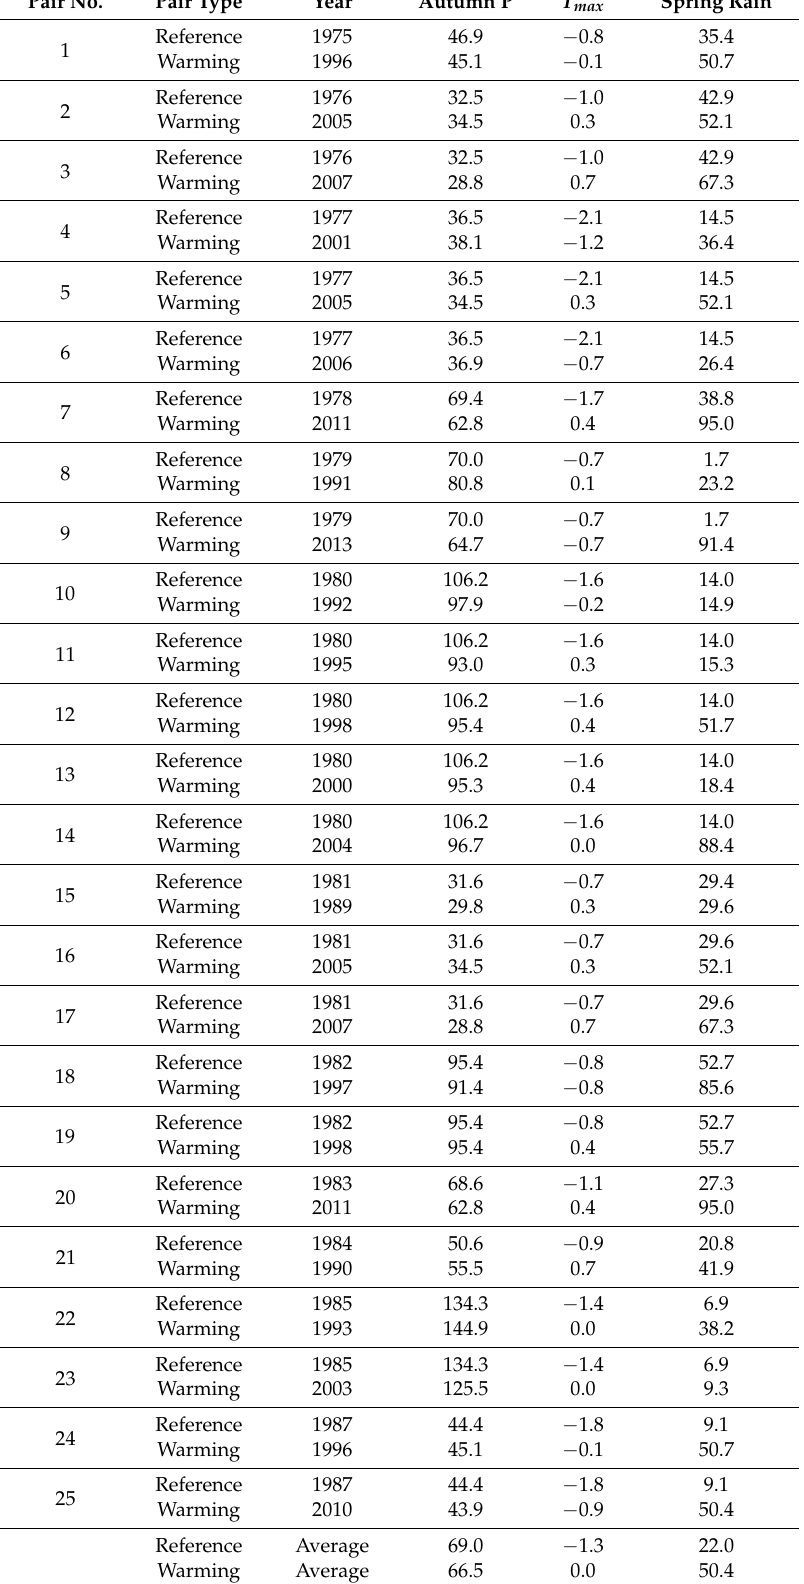
Table A6. Selected pairs for quantifying the effect of climate warming on high flow timing in the GR watershed. Pair